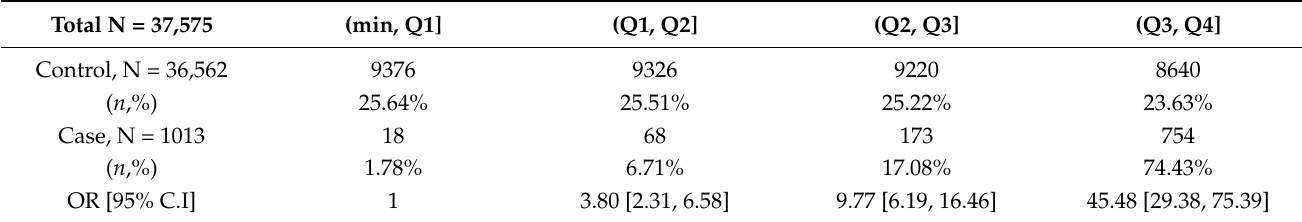
Table 4. Distribution of glaucoma cases and controls according to polygenic risk score (PRS) quantiles.